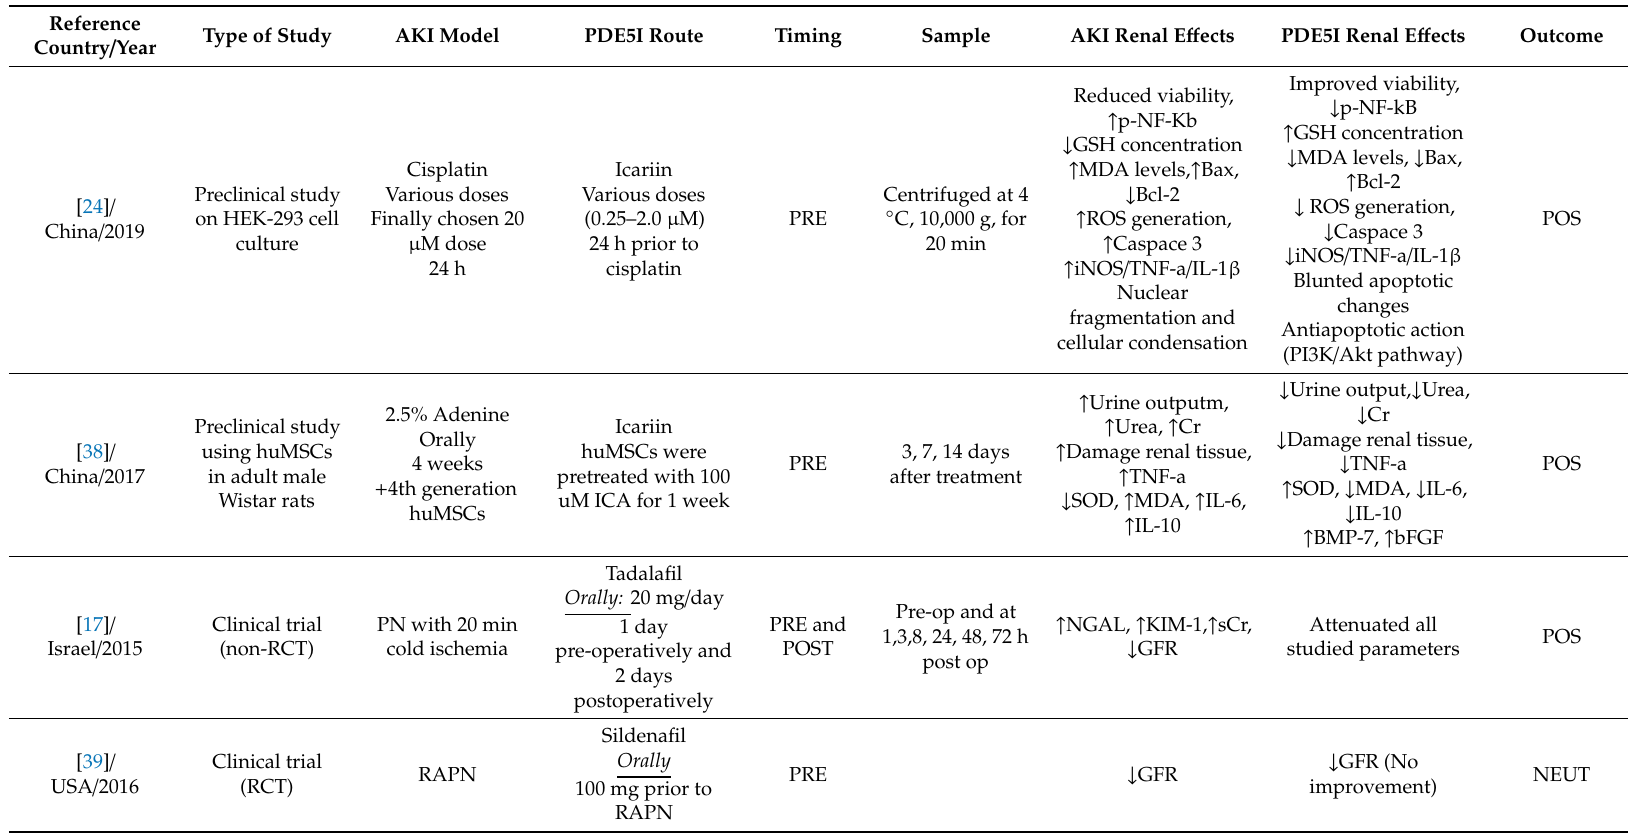
Table 1. Human studies evaluating the potential reno-protective e ff ects of phosphodiesterase 5